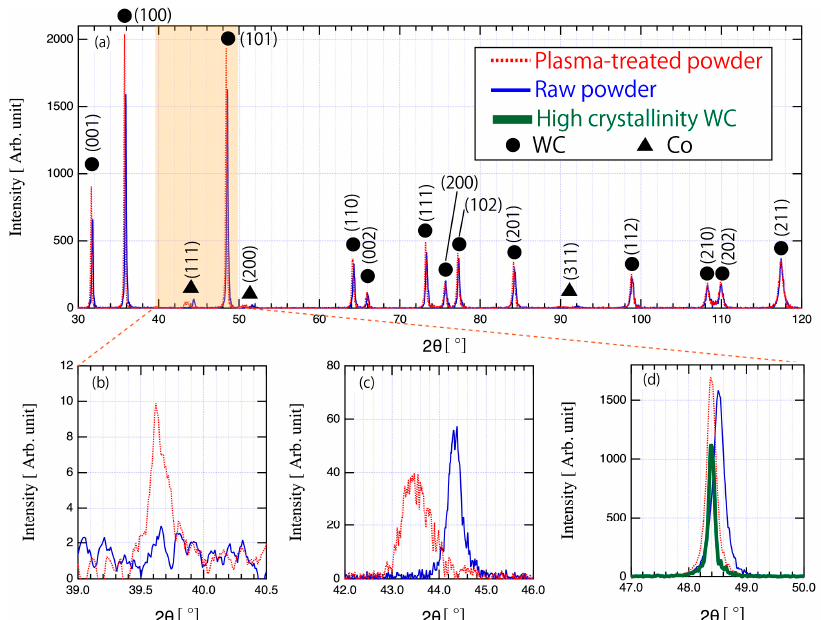
Figure 11. XRD profiles of raw powder and plasma-treated powder at various diffraction angles: ( a ) 30 to 120°, ( b ) 39.0 to 40.5°, ( c ) 42.0 to 46.0°, and ( d ) 47.0 to 50.0°. Red dashed line, blue solid line, and green bold line indicate the plasma treated powder, the raw powder, and the high crystallinity WC powder, respectively. Table 3. Calculated lattice constants of the raw powder and the plasma-treated powder.